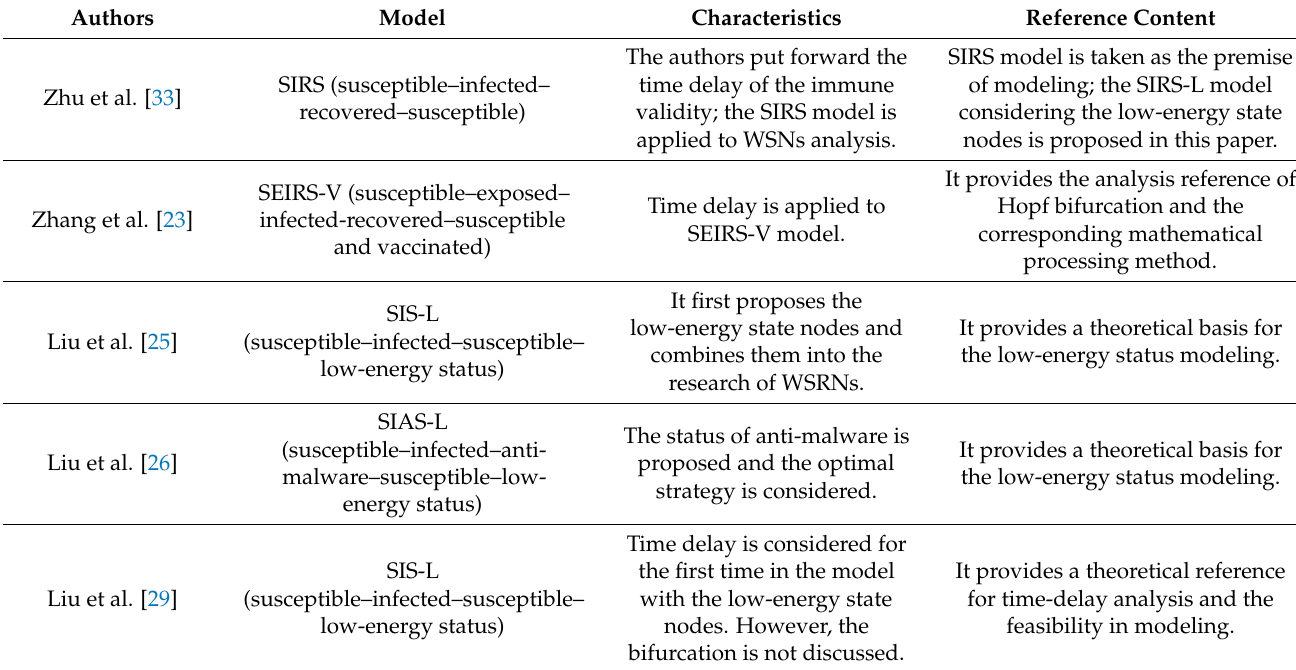
Table 1. Related research on the modeling and analysis of this